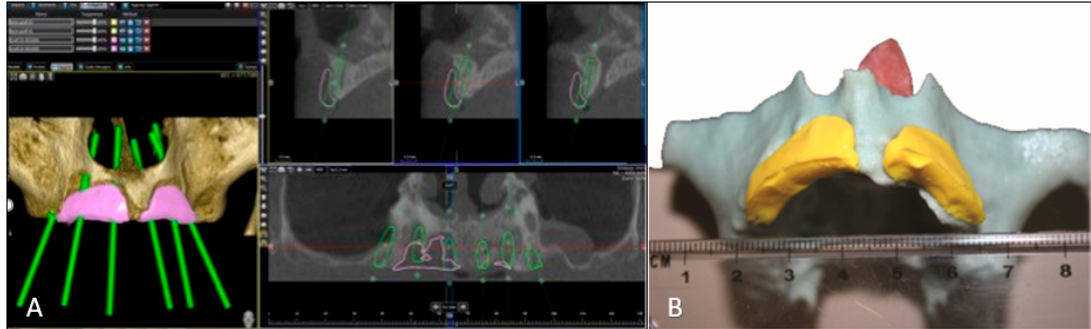
Figure 3. ( A ) Virtual planning of the surgical rehabilitation. ( B ) Stereolithographic model of the 3D resin reconstruction .